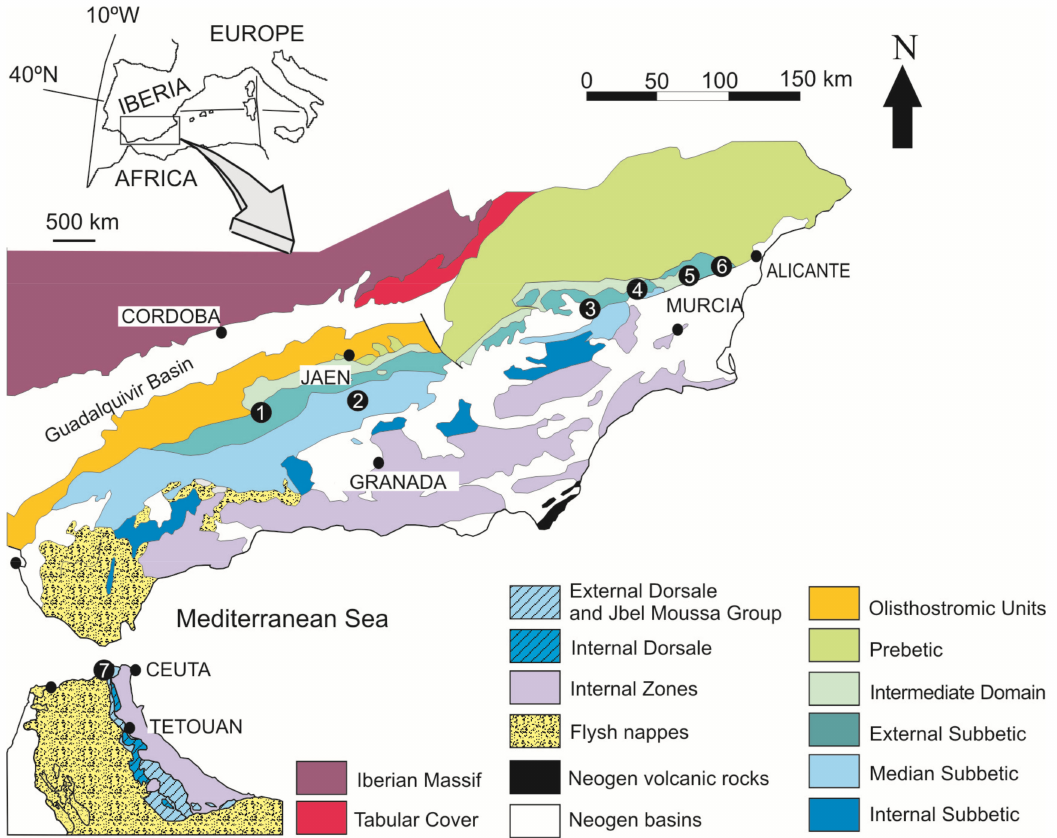
Figure 1. Geological setting of the studied outcrops in the Betic-Rifian Cordillera. (1) Cabra outcrop, (2) Carretero outcrop, (3) Qu í par outcrop, (4) L ú gar outcrops, (5) Capr é s outcrop, (6) Rambla Honda outcrop, (7) Ras